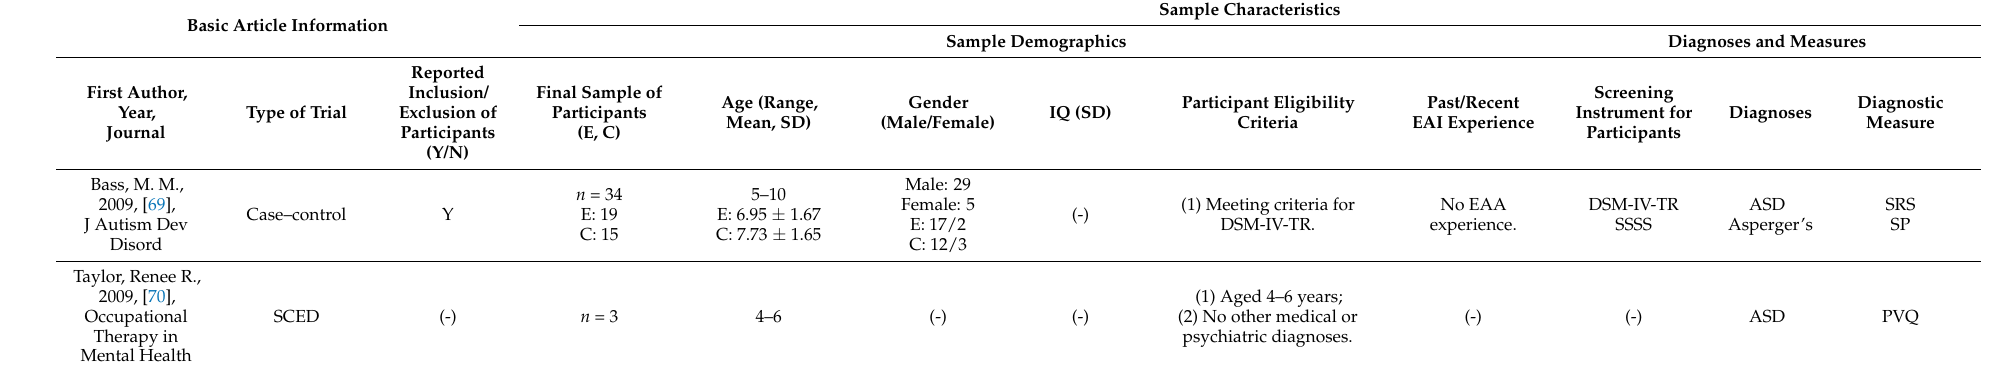
Table chronologically sorted and abbreviations alphabetically ordered as follows: (-): not reported; Y: yes; N: no; E: experimental group; C: control group; n/a: not applicable; n: number; BA: barn activity; Type of Trial: SCED: single-case experimental design; Final sample of participants: n = 18 *, initial sample = 25; BA: barn activities; CT: conventional therapy; EAAs: equine-assisted activities; EAT: equine-assisted therapy; HR: horseback riding; OTEE: occupational therapy in equine environment; PT: physical therapy; RA: regular activity; SC: social circle; THR: therapeutic horseback riding; Participant eligibility criteria: ABC-C: Aberrant Behavior Checklist—Community; NVIQ: nonverbal IQ; PATH Intl.: Professional Association of Therapeutic Horsemanship International; WISC- Ш : Wechsler Intelligence Scale for Children III; Screening Instruments: ABAS: Adaptive Behavior Assessment System; ABC-C: Aberrant Behavior Checklist—Community; ADOS: Autism Diagnostic Observation Schedule; CAB-T: Clinical Assessment Battery Teacher Rating Form; CARS: Childhood Autism Rating Scale; DSM: Diagnostic and Statistical Manual of Mental Disorders; Leiter: Leiter International Performance Scale; SCQ: Social Communication Questionnaire; SSSS: Stone’s Social Skills Scale; VABS: Vineland Adaptive Behavior Scale; Diagnosis: AD: anxiety disorder; ADHD: attention-deficit/hyperactivity disorder; CPD: community psychiatric diagnoses; HSID: hypersensitivity and sensory integration disorder; ID: intellectual disability; LD: learning disability; MD: mood disorder; PD: psychotic disorder; SD: seizure disorder; TC: tuberous sclerosis; Diagnostic Measure: ABLLS-R: Assessment of Basic Language and Learning Skills—Revised; APAS: Ariel Performance Analysis System; BOT: Bruininks–Oseretsky Test of Motor Proficiency; BSID-2: Cognitive Domain of Bayley Scales of Infant Development 2; CBC: Child Behavior Checklist; CGAS: Children’s Global Assessment Scale; CHQ: Child Health Questionnaire; DCDQ’07: Developmental Coordination Disorder Questionnaire, as revised in 2007; ELISA: competitive enzyme immune essay method; EQ/SQ: empathizing quotient/systemizing quotient; FAD: McMaster Family Assessment Device; GARS-2: Gilliam Autism Rating Scale 2; GAS: Goal Attainment Scale; HCC: hair cortisol content; IEMS: interaction emotions motor skills; IPA: interpretive phenomenological analysis; K-ABC-2: Kaufman Assessment Battery for Children 2; KTEA-2: Kaufman Test of Educational Achievement—Second Edition; PAC-test: Pedagogical Analysis and Curriculum; PEDI-CAT ASD: Pediatric Evaluation of Disability Inventory Computer Adaptive Test, Autism Spectrum Disorder Module; MOPI: observational measure of child’s engagement; PedsQL: Pediatric Quality of Life 4.0 Generic Core Scales; PPVT-4: Peabody Picture Vocabulary Test, Fourth Edition; PRES: Preschool Receptive–Expressive Language Scale; PSI-SF: Parenting Stress Index—Short Form; PVQ: Pediatric Volitional Questionnaire; QLES-Q: Quality of Life Enjoyment and Satisfaction Questionnaire; REVT: Receptive and Expressive Vocabulary Test; SALT: Systematic Analysis of Language Transcripts; SIPT: Sensory Integration and Praxis Test; SP: Sensory Profile; SPSC: Sensory Profile School Companion; SRS: Social Responsiveness Scale; SSIS-RS: Social Skills Improvement System Rating Scale; TSIF: Test of Sensory Integration Function; TOL: Tower of London; TSS: Treatment Satisfaction Survey; TSSA: Triad Social Skills Assessment; VAS: Visual Analog